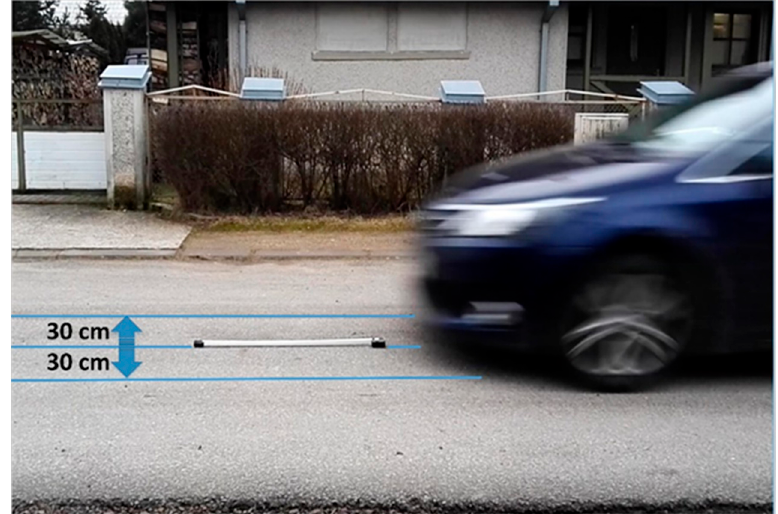
Figure 4. The measuring system placed on a road lane. A car is driven centrally (C) along a lane axis or non-centrally-with 30 cm shift to the right (R) or to the left (L).